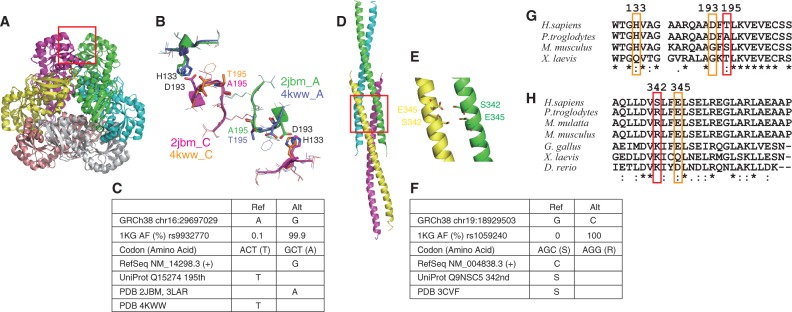
Protein 3D structures including rare variants. (A) Superimposition of two quinolic acid phosphoribosyl transferase (QPTR) hexamers. (B) Dimer–dimer interface of QPTR surrounding the variant residues A195T. Chain As of PDB entries 2JBM and 2KWW are green and purple, respectively and their chain Cs are magenta and orange, respectively. (C) A rare variant in QPTR. (D) Structure of HOMER protein homologue 3 (HOMER3) coiled-coil domains and (E) close-up view with the S342 and E345 residues. (F) A rare variant in HOMER3. (G, H) Sequence comparisons of (G) QPTR and (H) HOMER3.